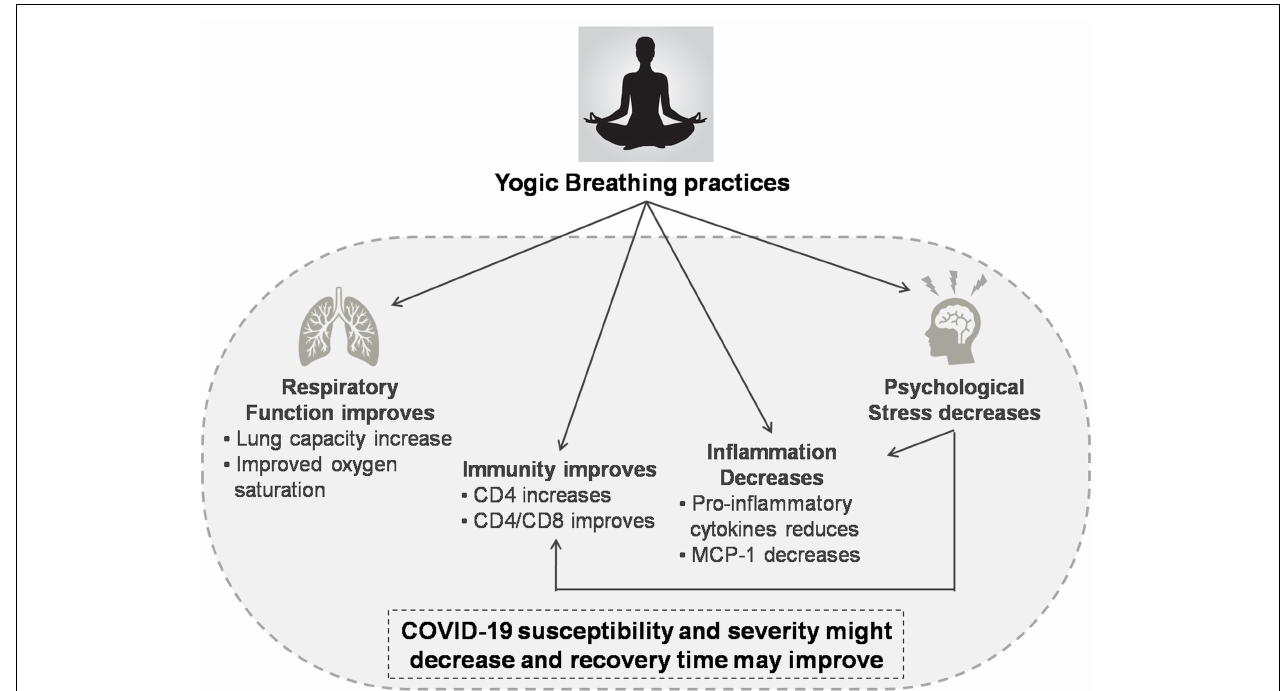
FIGURE 1 | Effects of Yogic breathing and probable advantage in COVID-19. Abbreviations: CD4, cluster of differentiation 4; CD8, cluster of differentiation 8; and MCP-1, Monocyte chemoattractant protein-1.